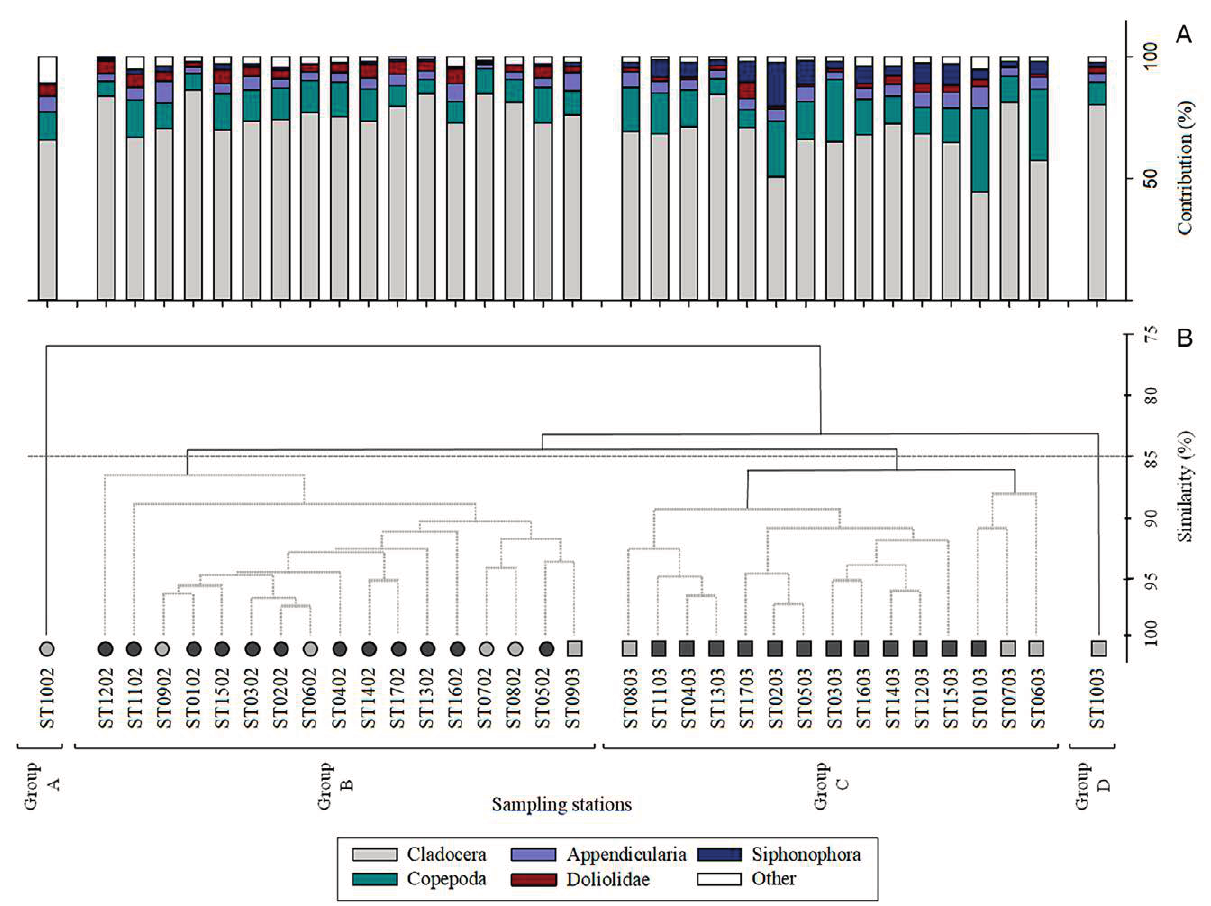
Fig. 4. – A, percentage contribution of dominant mesozooplankton groups to total abundance in a grid of 17 stations in Kavala Gulf in summer 2002 and 2003. B, dendrogram of Bray-Curtis similarity index of mesozooplankton community among samplings in sampling grid in Kavala Gulf from hierarchical agglomerative cluster analysis in log x+1 transformed data of zooplankton group abundance. Solid black lines indicate significant branches based on SIMPROF permutation tests, while dashed light grey lines indicate non-significant divisions (P<0.05). Symbols coded for sampling year and maximum depth categories; light grey cycles for shallow stations in 2002 and dark grey cycles for deeper stations in 2002; light grey squares for shallow stations in 2003 and dark grey squares for deeper stations in 2003. Sampling abbreviations are consis- tent with the formula ST (number of station) (sampling year; 02 for 2002 and 03 for 2003).